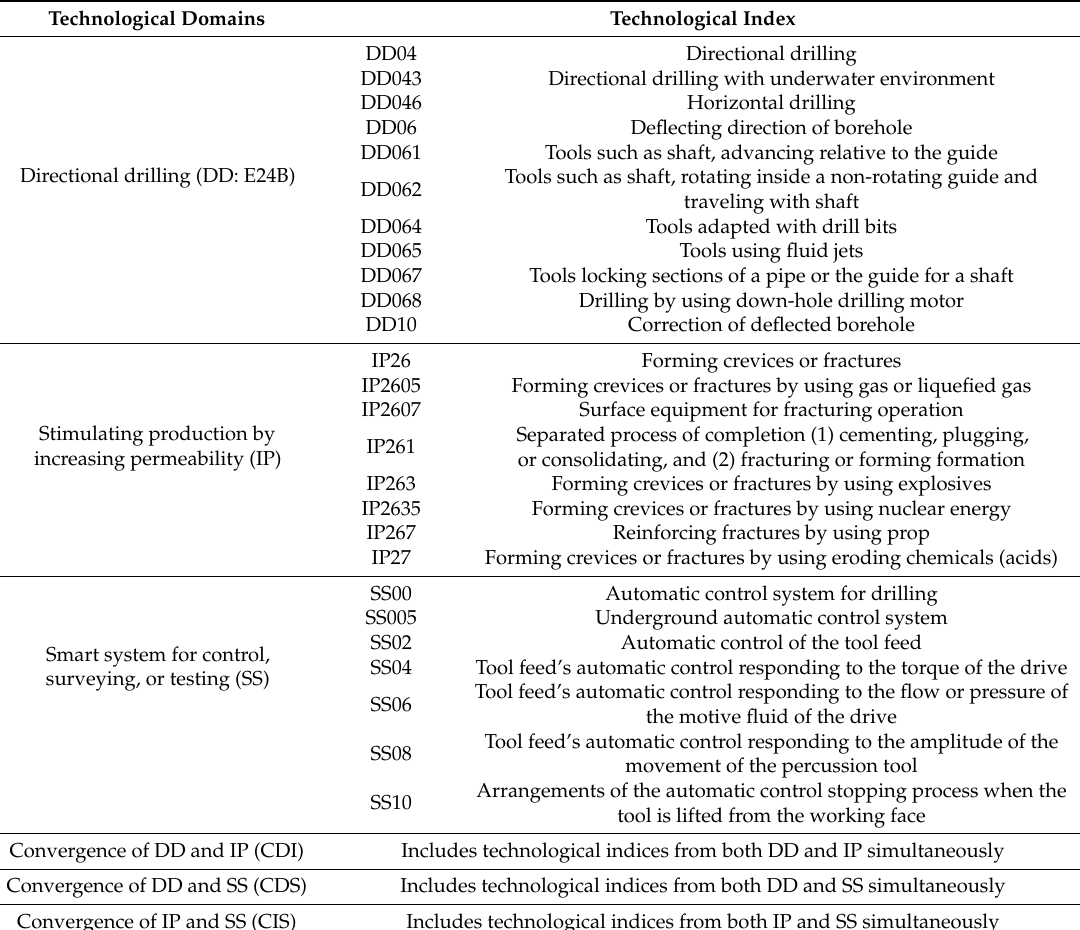
Table 1. Description of technological indices (TIs) by technological domains